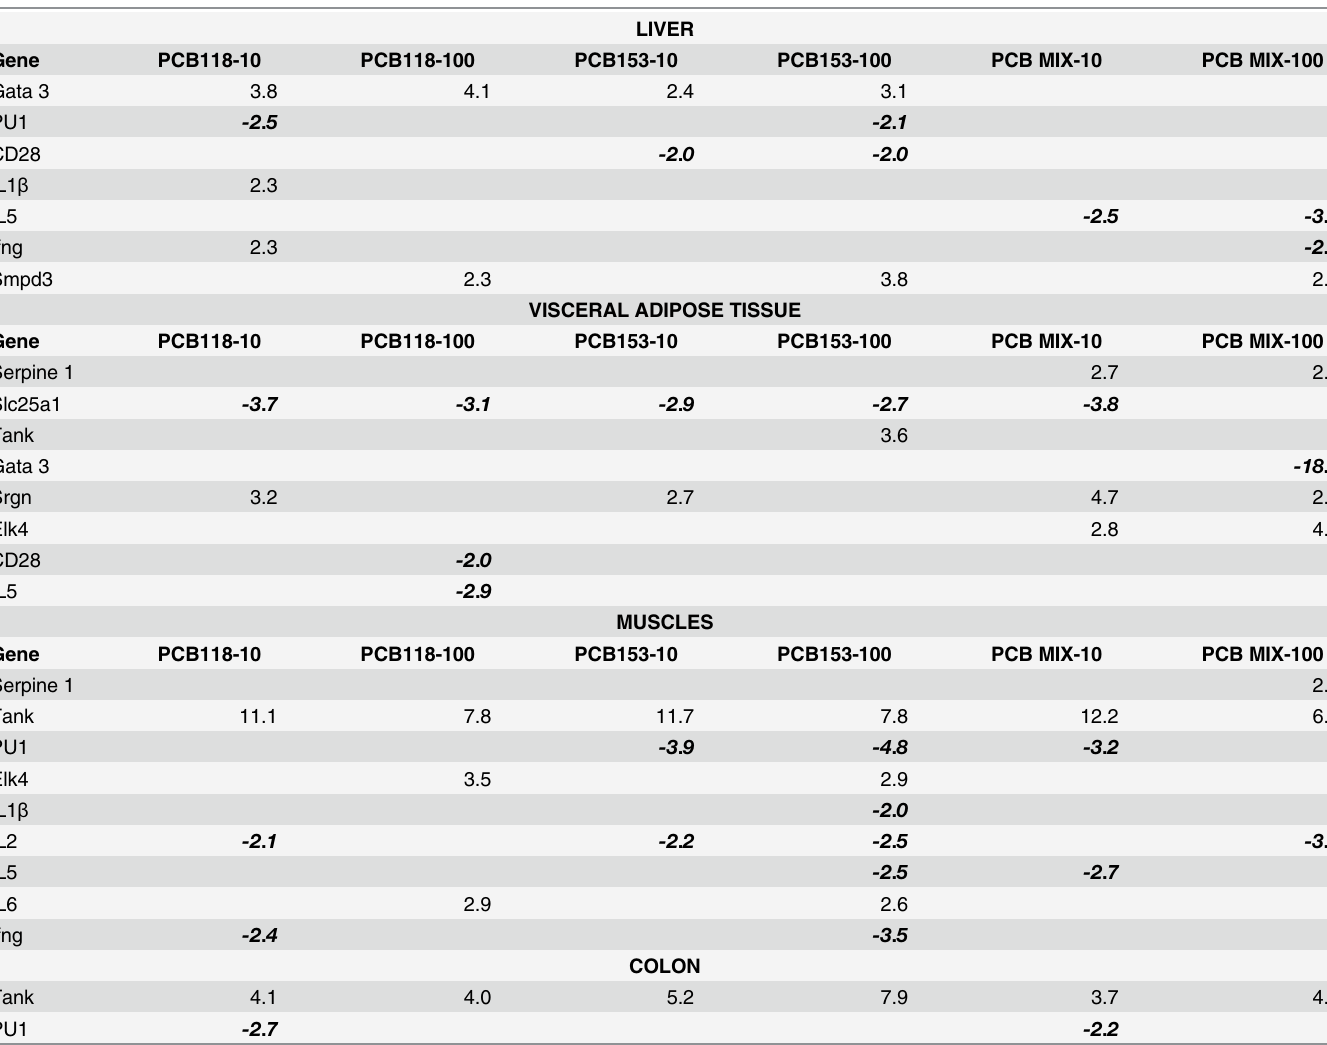
Table 7. Genes involved in inflammation and the immune system based on microarray